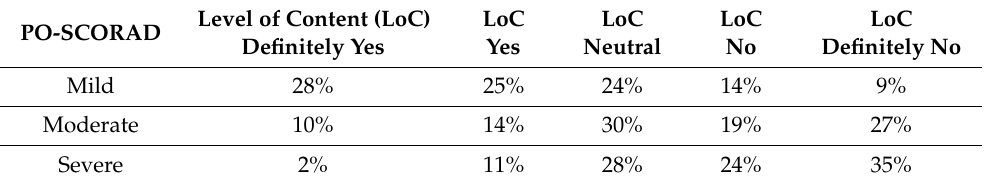
Table 4. Level of content within patients using telemedicine during the COVID pandemic.